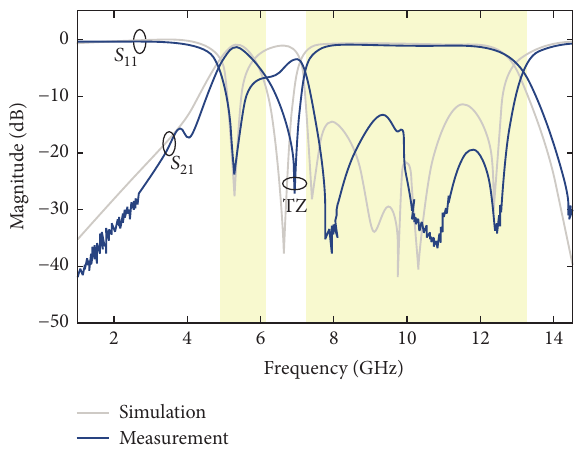
Figure 8: The simulated and measured